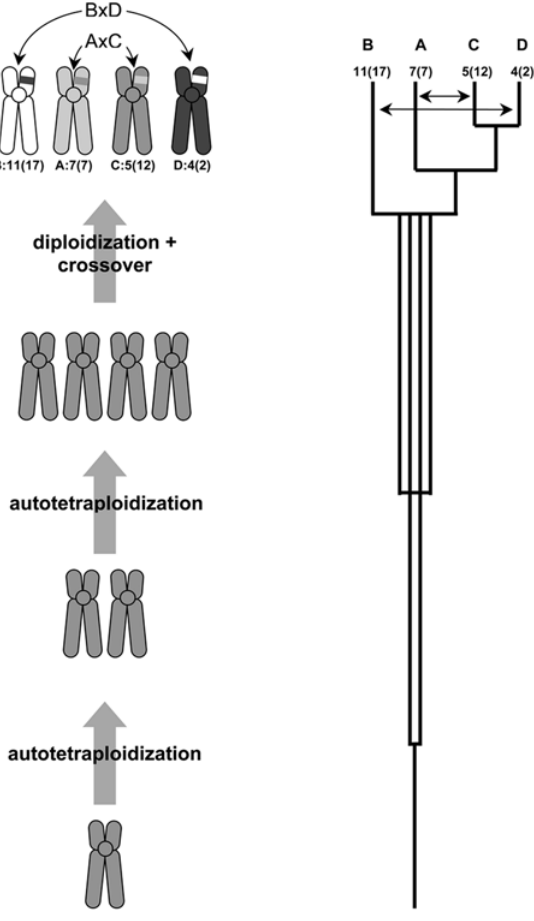
Figure 5. Reconstruction of the Hox cluster duplication history. If genome duplications occur in close succession, diploidization will be sequential from an octoploid or pseudo-octoploid state. Gene trees will then reflect the order of diploidization of chromosomes, rather than the order of chromosome duplication and the tree topology will be sequential (after Furlong and Holland 2001). Resolving the incongruent gene tree topologies for Dlx/Col and Hox/ErbB genes requires two chromosomal rearrangements between chromosomes carrying the HoxB and D clusters ( BxD ) and HoxA and C clusters ( AxC ) in the intergenic region between the collagen genes and the Hox13 paralogs. Chromosomes are labeled with respect to Hox cluster ( A–D ), the chromosomal location of that Hox cluster in the human genome and the chromosomal location in the vertebrate ancestor (ancestral karyotype information from (Kohn et al., 2006); shown as Hox cluster: ancestral vertebrate chromosome (human chromosome). Double-sided arrows indicate crossover